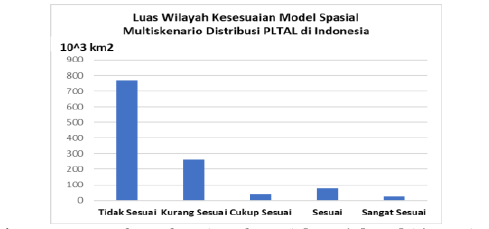
Figure 6 Area of Conformity of Spatial Model Multiskenario Distribution pltal in Indonesia